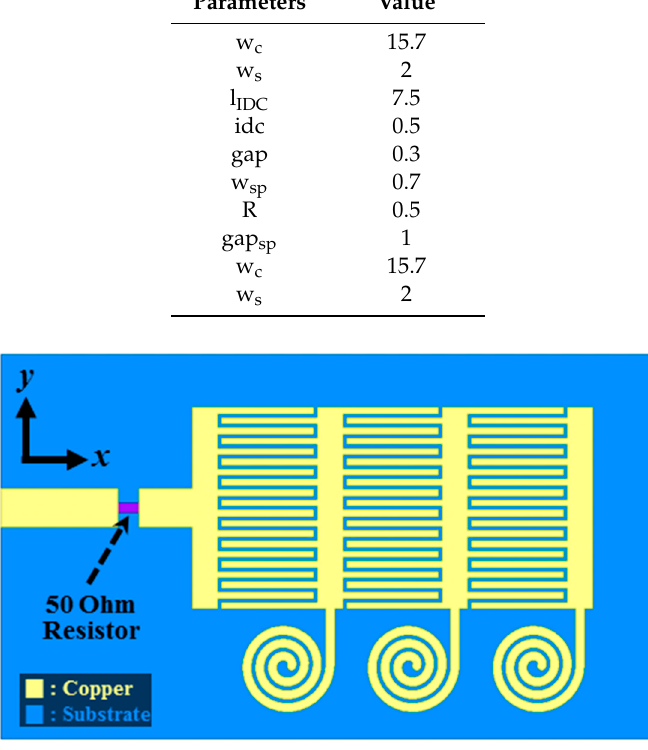
Figure 11. Designed CRLH transmission line antenna. Table 3. Parameters of the CRLH TL unit cell.